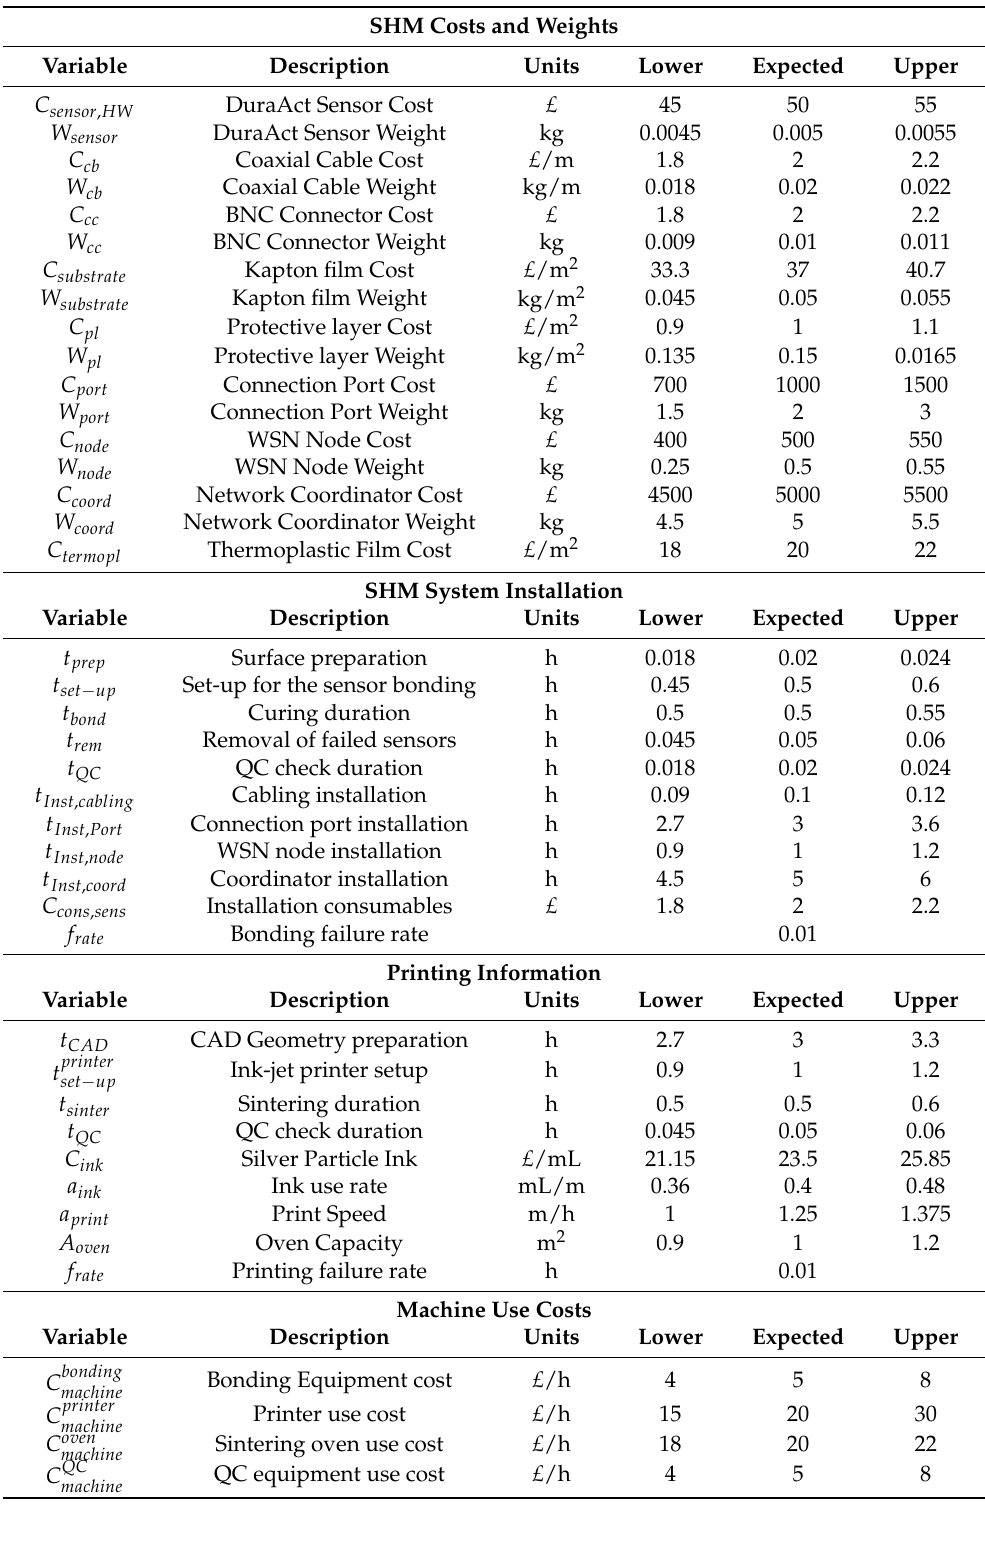
Table 2. Cost and weight data for the SHM system